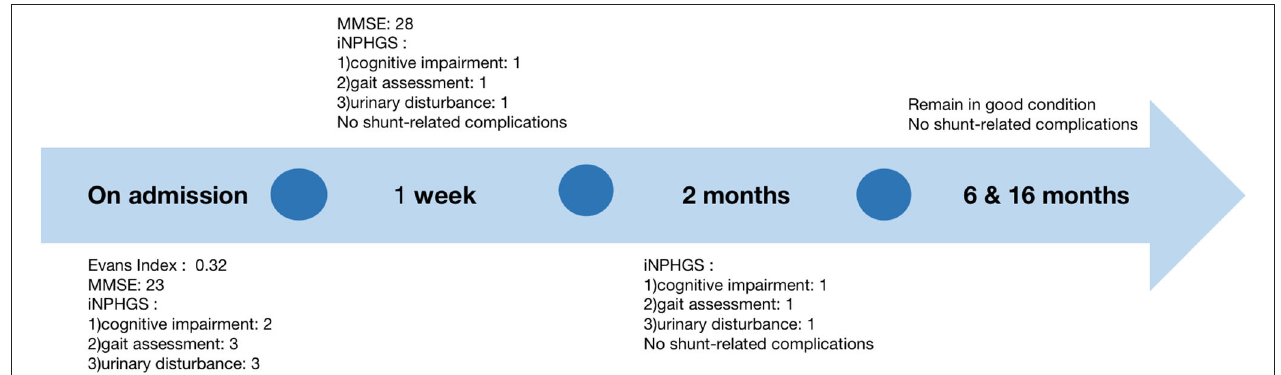
FIGURE 3 | A timeline of the follow-up of the